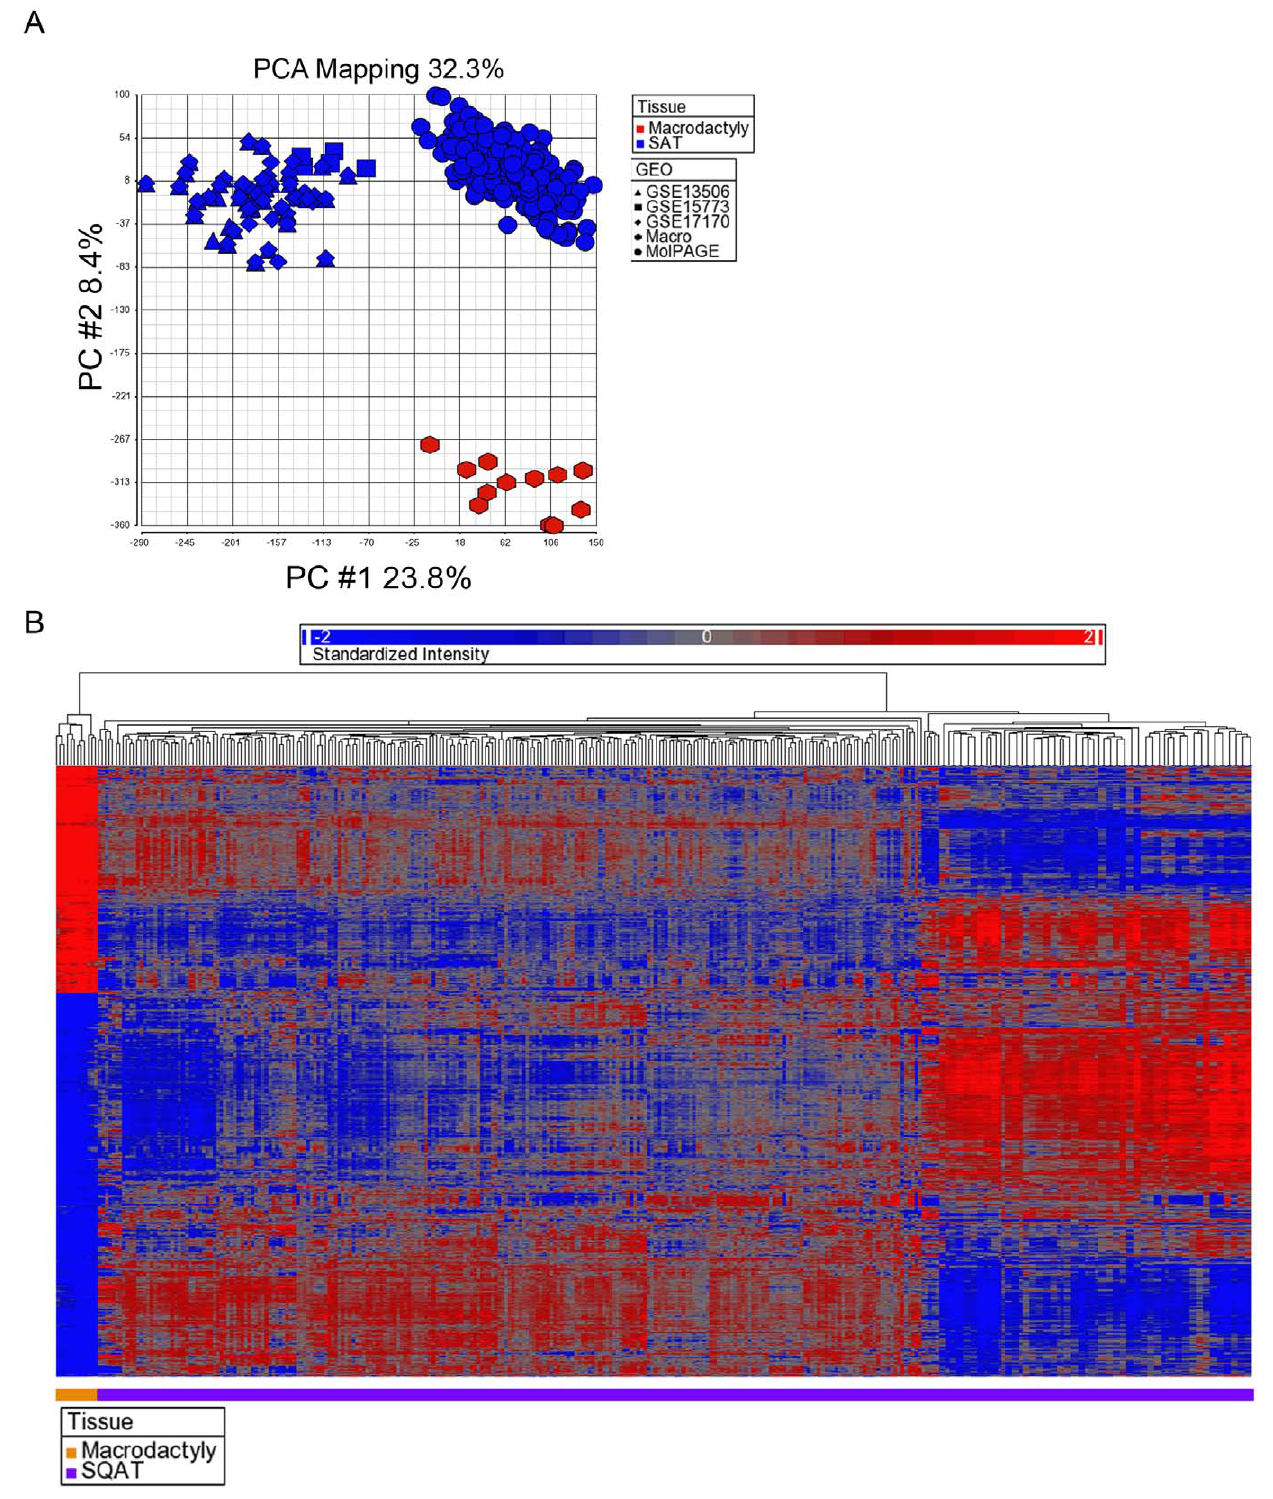
Figure 2. Results of principal component analysis (PCA) and hierarchical clustering of gene expression date from macrodactyly samples. (A) PCA of 4 macrodactyly samples (in triplicate) vs. 345 subcutaneous adipose tissue (SAT) samples. The top 2 vectors account 32.3% of intersample variation. Macrodactyly samples cluster distinctly from SAT. (B) Hierarchical clustering of macrodactyly and SAT samples across differentially expressed genes with fold-change . 1.5, p-value , 0.05, and false discovery rate , 0.05. Macrodactyly samples cluster distinctly and distantly from all SAT samples.